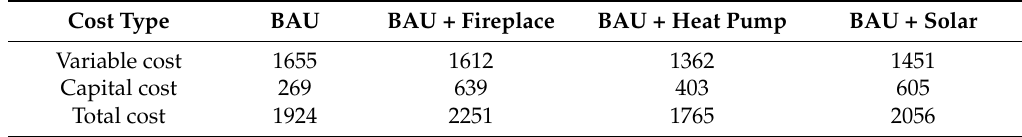
Table 3. Annualized costs ( € /a) of the heating system in the different cases.